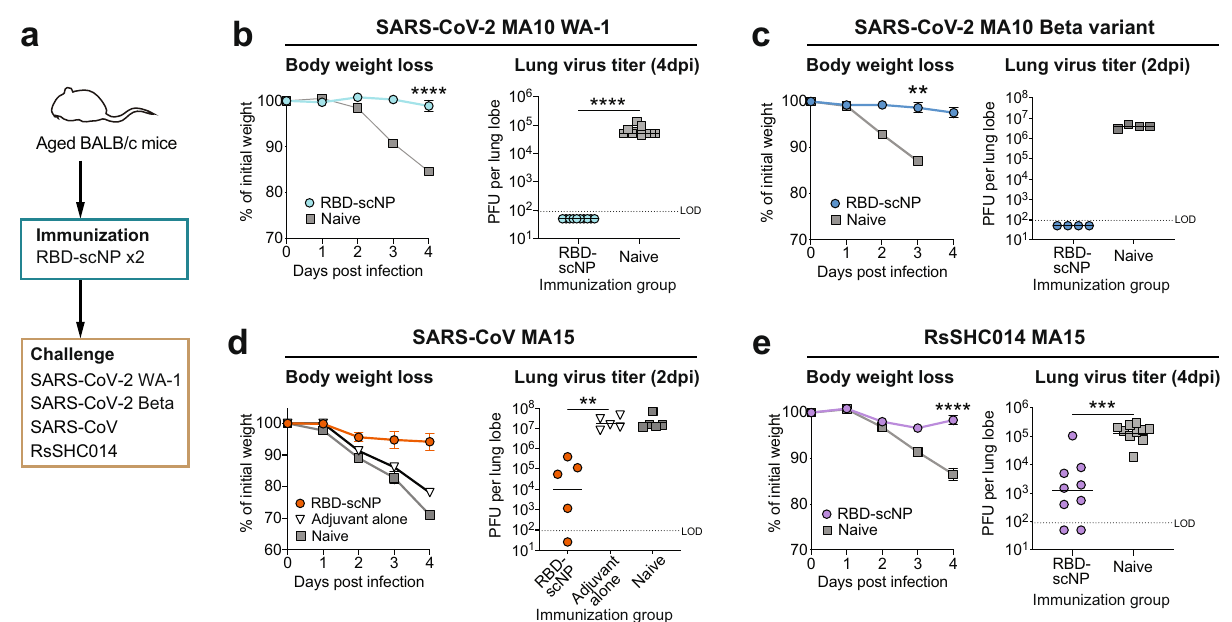
Fig. 5 | Two doses of RBD-scNP vaccination protected mice from challenges of SARS-CoV-2 variants and other betacoronaviruses. a Schematic of the mouse challenge studies. 11-month-old female BALB/c mice ( n =10 per group) were immunized intramuscularly twice with adjuvanted RBD-scNP and challenged with SARS-CoV-2mouse-adapted10(MA10)WA-1,SARS-CoV-2MA10Betavariant,SARS- CoV-1mouse-adapted15(MA15),orBatcoronavirus(CoV)RsSHC014MA15.GLA-SE wasused asadjuvant in the SARS-CoVchallengestudy, and 3M-052-Alum wasused intheotherchallengestudies. b Weightloss( n =10pergroup)andlungvirustiters ( n =10 per group) at 4 days post-infection (dpi) of the SARS-CoV-2 MA10 WA-1